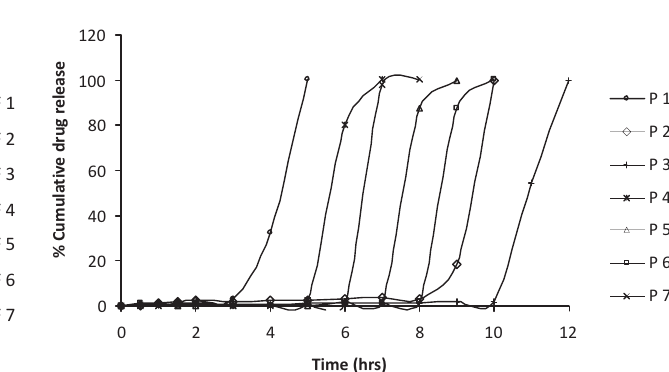
FIGURE 2 - Dissolution profiles of CCT using PEO WSR 301 as coating polymer F 1-7. (mean±s.d., n=3).